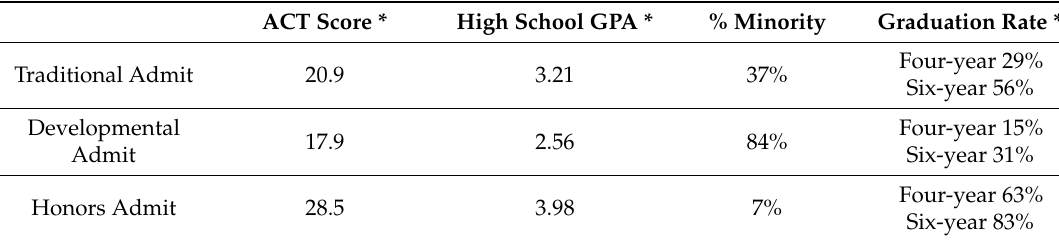
Table 1. Embedded Cases: New First-Year Student Profile, 2016.